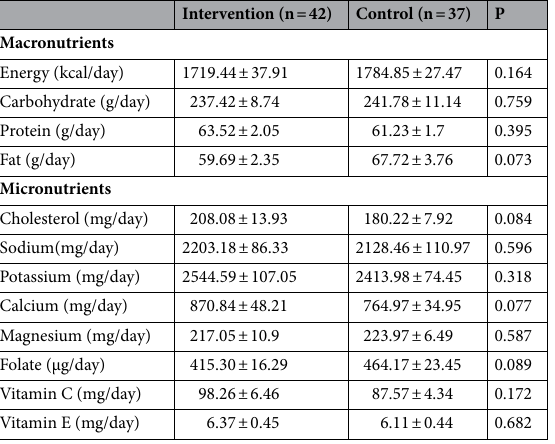
Table 2. Dietary intakes of participants, obtained from two dietary records, throughout the study (n = 79). 1 All values are means ± SE. P resulted by independent t-test.